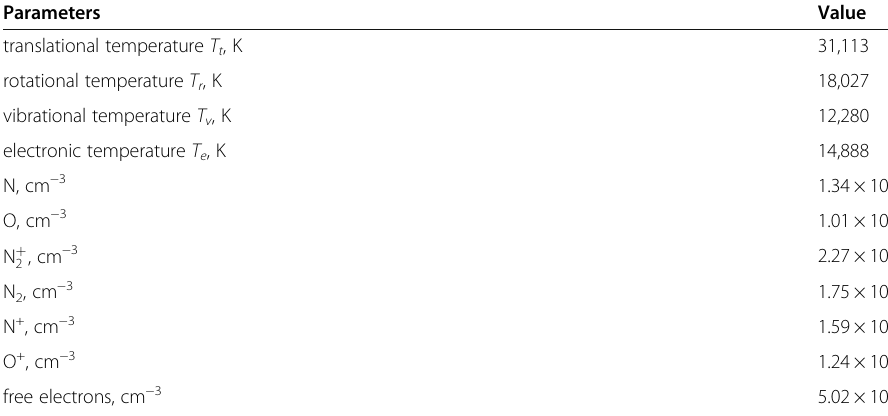
Table 2 The condition of the air plasma cell Parameters Value translational temperature T t , K rotational temperature T r , K vibrational temperature T v ,